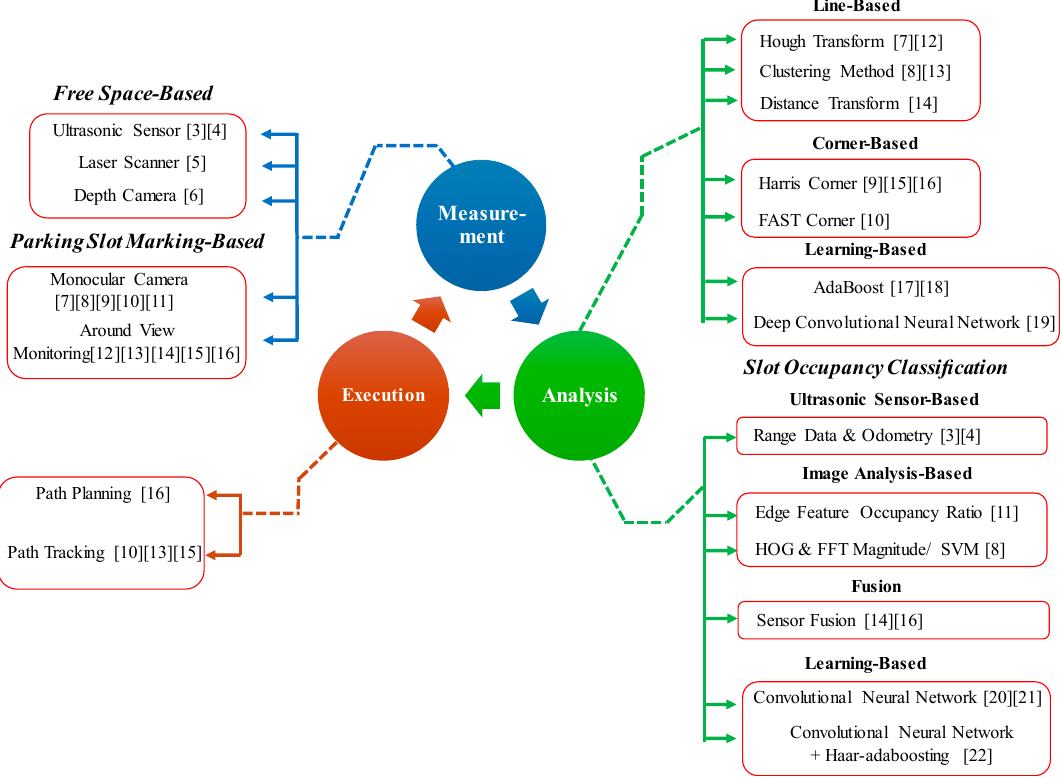
Figure 2. Classification of current literature based on the automated parking cycle.